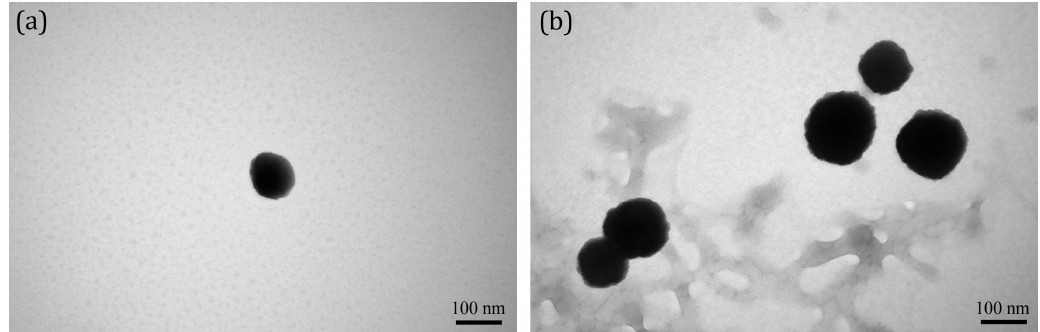
Figure 2. Transmission electron microscope (TEM) images of: ( a ) PS80 PBCA NC; and ( b ) PS80 PBCA NC/HRE-cmvBDNF, ×200,000.